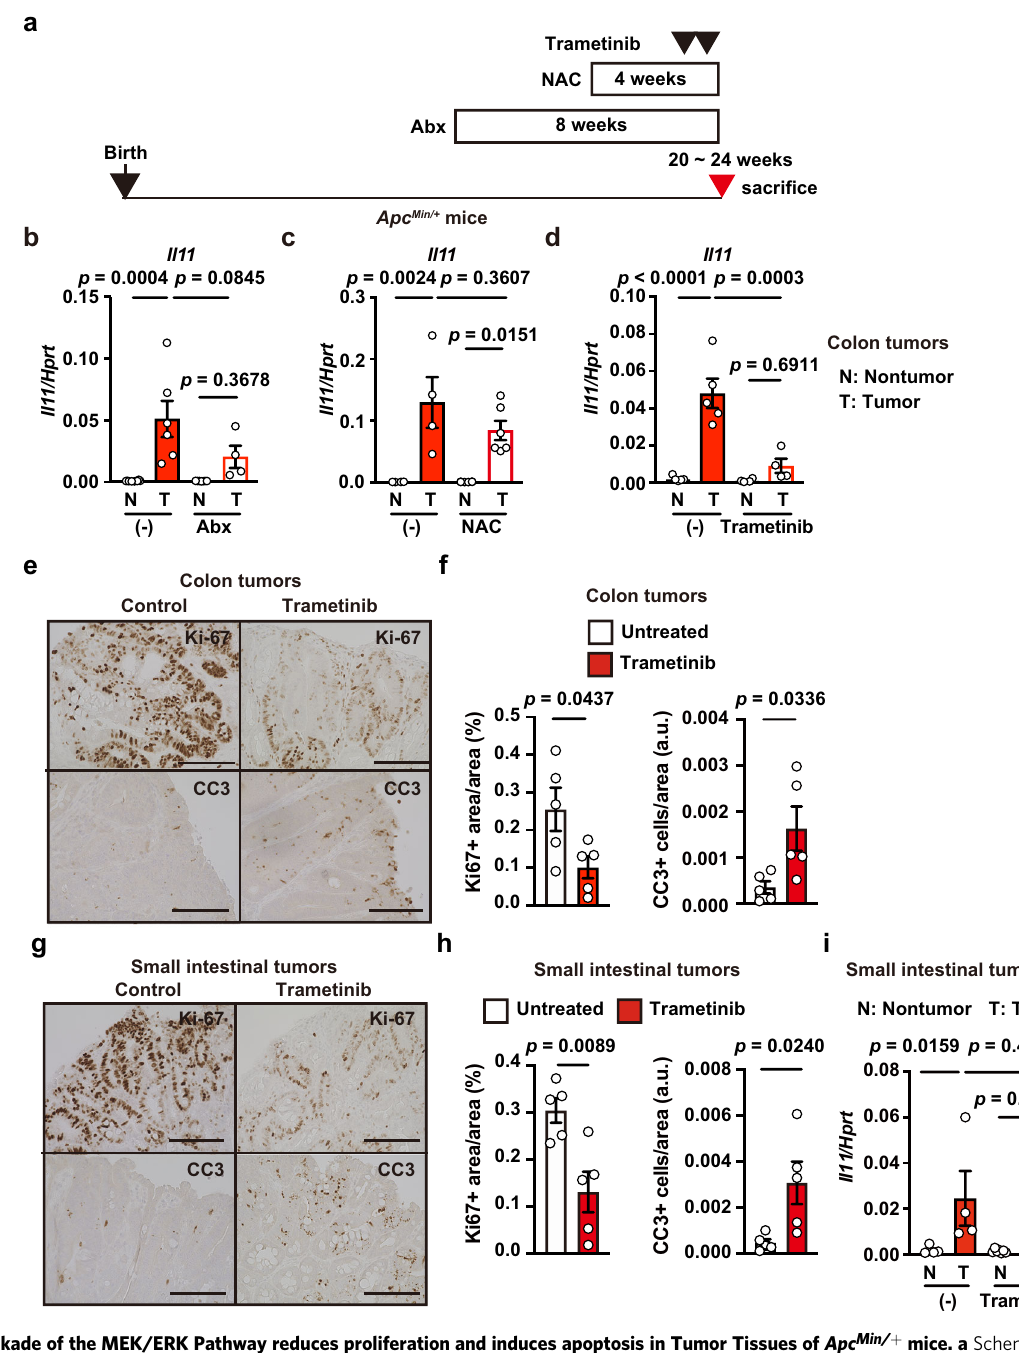
Fig. 7 Blockade of the MEK/ERK Pathway reduces proliferation and induces apoptosis in Tumor Tissues of Apc Min/ + mice. a Schema of administration of various inhibitors to Apc Min/ + mice. b – i Apc Min/ + mice were not treated or treated with Abx for 8 weeks ( b ), NAC for 4 weeks ( c ), or trametinib at – 6 and – 30 h ( d – i ), then sacri fi ced 20 – 24 weeks after birth. b – d Il11 expression in tumors and nontumor tissues in the colon was determined using qPCR. Results are mean ± SEM. n = 8 (nontumor, untreated), 6 (tumor, untreated), 7 (nontumor, Abx-treated) or 4 (tumors, Abx-treated) mice; pooled data from three independent experiments. n = 4 (untreated) or 6 (NAC-treated) mice; pooled data from two independent experiments. n = 5 (untreated) or 4 (trametinib-treated) mice; pooled data from three independent experiments. Colon ( e ) or small intestine ( g ) tumor tissue sections were stained with anti- Ki67 or anti-CC3 antibodies, and analyzed and are expressed as in Fig. 6f, g ( f , h ). Results are mean ± SEM ( n = 5 mice). Il11 expression in tumors and nontumor tissues in the small intestine was determined using qPCR ( i ). Results are mean ± SEM. n = 4 (untreated) or 7 (trametinib-treated)